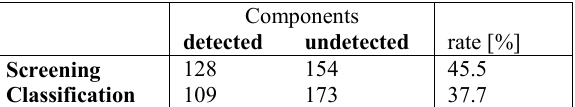
Table 4 . Detection rate of reference debris components.